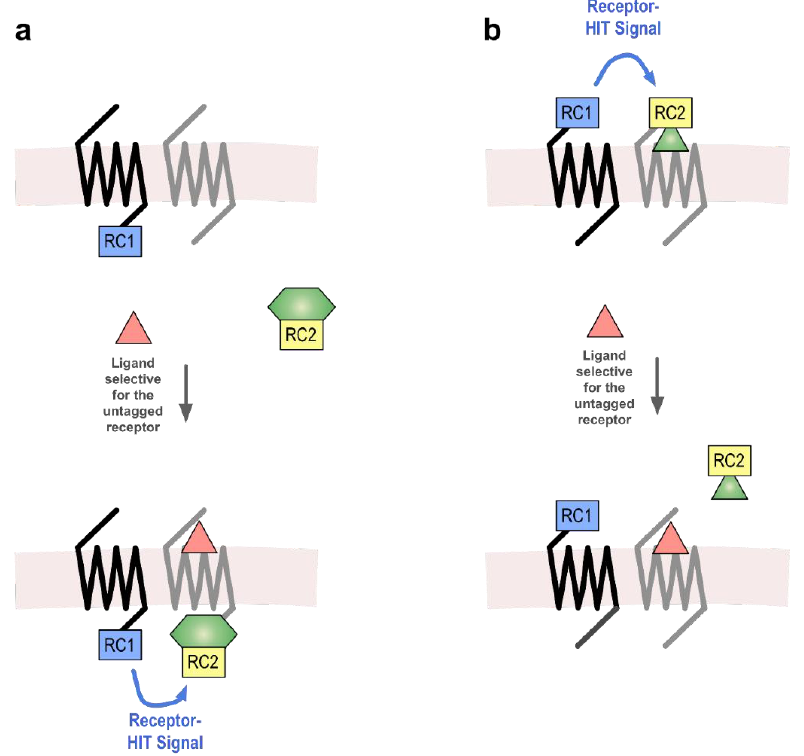
Figure 1. Intracellular and extracellular Receptor-Heteromer Investigation Technology (Receptor- HIT) assay . Receptor-HIT allows for investigation of receptor heteromers through ligand-dependent modulation of interactions between receptors and specific biomolecules. The Receptor-HIT assay uses a proximity-based reporter system such as bioluminescence or fluorescence resonance energy transfer (BRET or FRET) or protein complementation. The assay has most commonly been used to investigate GPCR heteromers (GPCR-HIT) [2] however it can be used to investigate any type of heteromers, such as RTK heteromers (RTK-HIT) [12]. The assay works by coexpressing each receptor in cells, one receptor tagged with the first reporter component of the proximity assay (RC1), such as a BRET donor, and the other receptor untagged with respect to the proximity assay system. Instead, an interacting biomolecule is tagged with the second reporter component (RC2), such as a BRET acceptor. Usually, this interacting biomolecule is a coexpressed intracellular protein ( a ) however it can also be a labeled ligand ( b ). The assay works by adding a ligand that is selective for the untagged receptor. If this results in modulation of the proximity signal between the tag on the receptor and the tag on the interacting biomolecule, this indicates heteromerization of the two receptors.